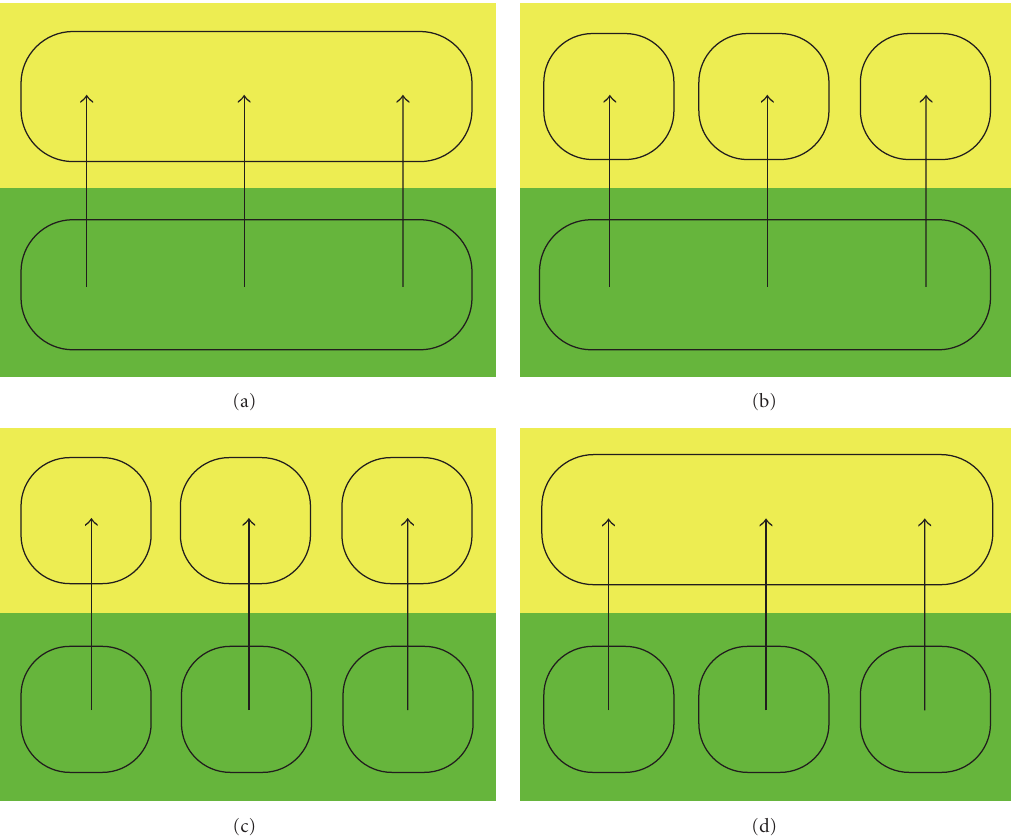
Figure 1: An illustration of several patterns in which multiple independent transitions to a new environment are coupled with speciation. The yellow and green boxes represent two di ff erent environments, the arrows represent multiple independent transitions between the environments, and the closed shapes represent reproductively compatible groups. Only panel (a) represents parallel ecological speciation, the process we are interested